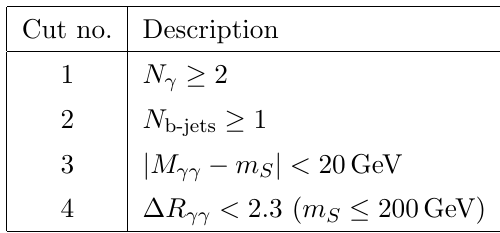
Table 2 . Selection cuts applied to the S ! (cid:13) (cid:13) signal region. The cuts are described in detail in the text. Refer to section 4.1 for the de(cid:12)nition of the objects.